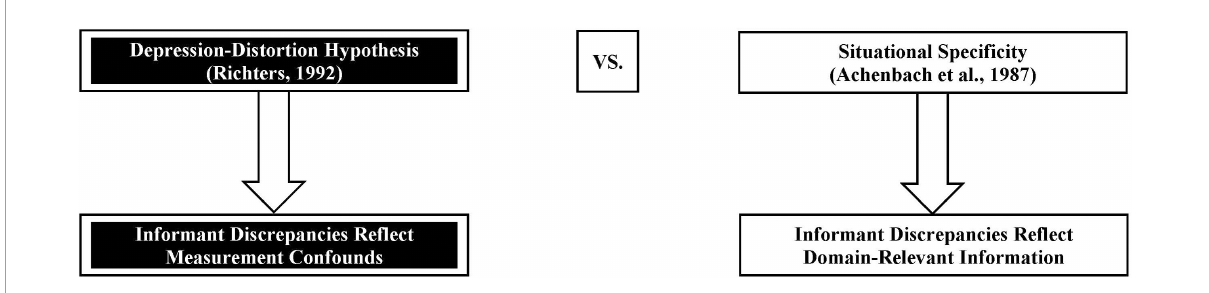
FIGURE1 How theory and research about informant discrepancies ought to inform decision-making on when to apply measurement invariance techniques to detect informant discrepancies in youth mental health research. In research on multi-informant assessments of youth mental health, competing theories exist for what informant discrepancies reflect. One theory (i.e., depression-distortion hypothesis; Richters, 1992) claims that discrepancies reflect mood-congruent rater biases, such that a negative mood state compels an informant (e.g., parent) to attend to, encode, recall, and rate more negative youth behaviors, relative to informants who do not experience such mood states (e.g., teacher); accordingly, informant discrepancies reflect measurement confounds. In contrast, the other theory (i.e., situational specificity; Achenbach et al., 1987) claims that discrepancies reflect the notion that youth vary in the contexts in which they display mental health concerns, and the informants from whom assessors solicit reports (e.g., parents, teachers, and youth) vary in the contexts in which they observe youth; accordingly, informant discrepancies reflect domain-relevant information.